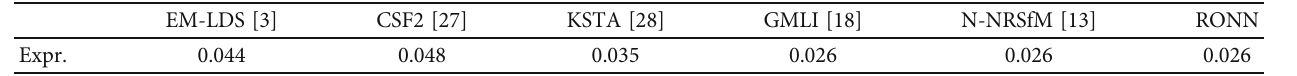
Table 5: e for the expression dataset 3 D